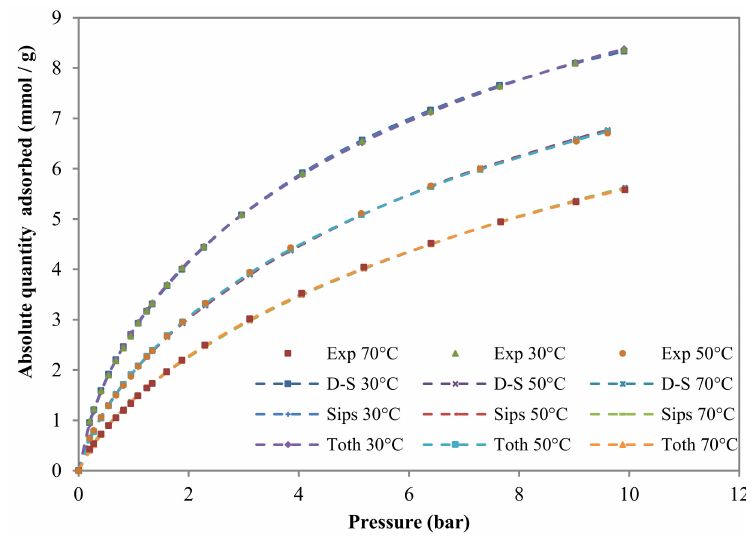
Figure 5. CO 2 isotherm at different temperatures (dashed line with symbols for Sips, Dual-Site Langmuir and Toth models fitting and symbols for experimental